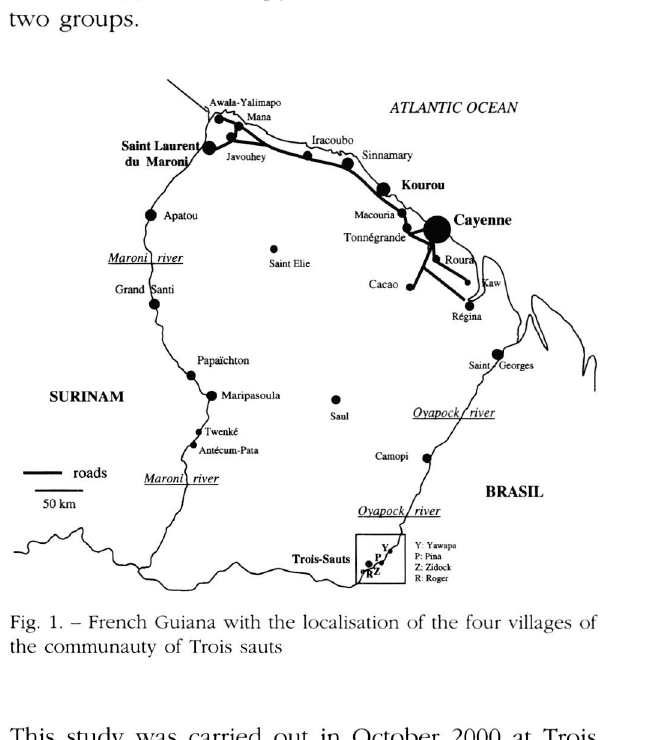
This study was carried out in October Sauts (latitude 2.5° north, longitude 5° west), a com munity located in the upper reaches of the